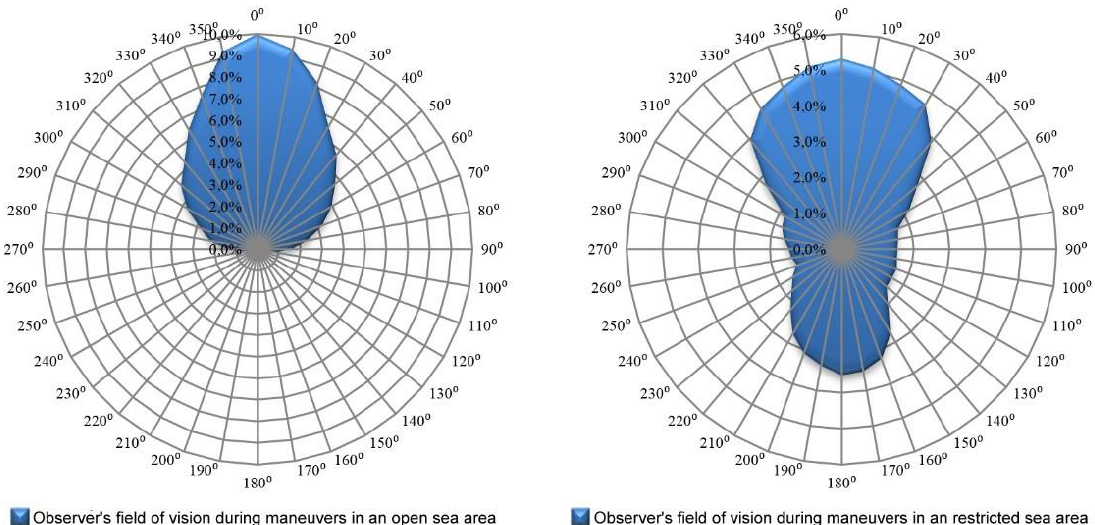
Figure 6. The distribution of the observer’s field of vision during maneuvers in an open sea area and restricted sea area.